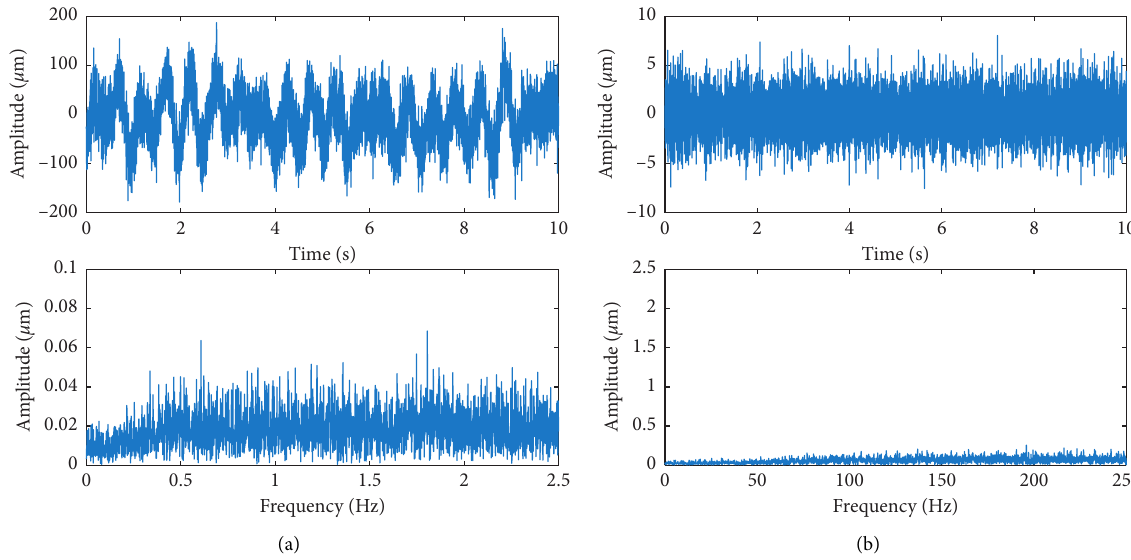
Figure 8: Actual signal processed by ITD. (a) Y -direction swing signal at the flange. (b) Vibration signal at the draft tube.